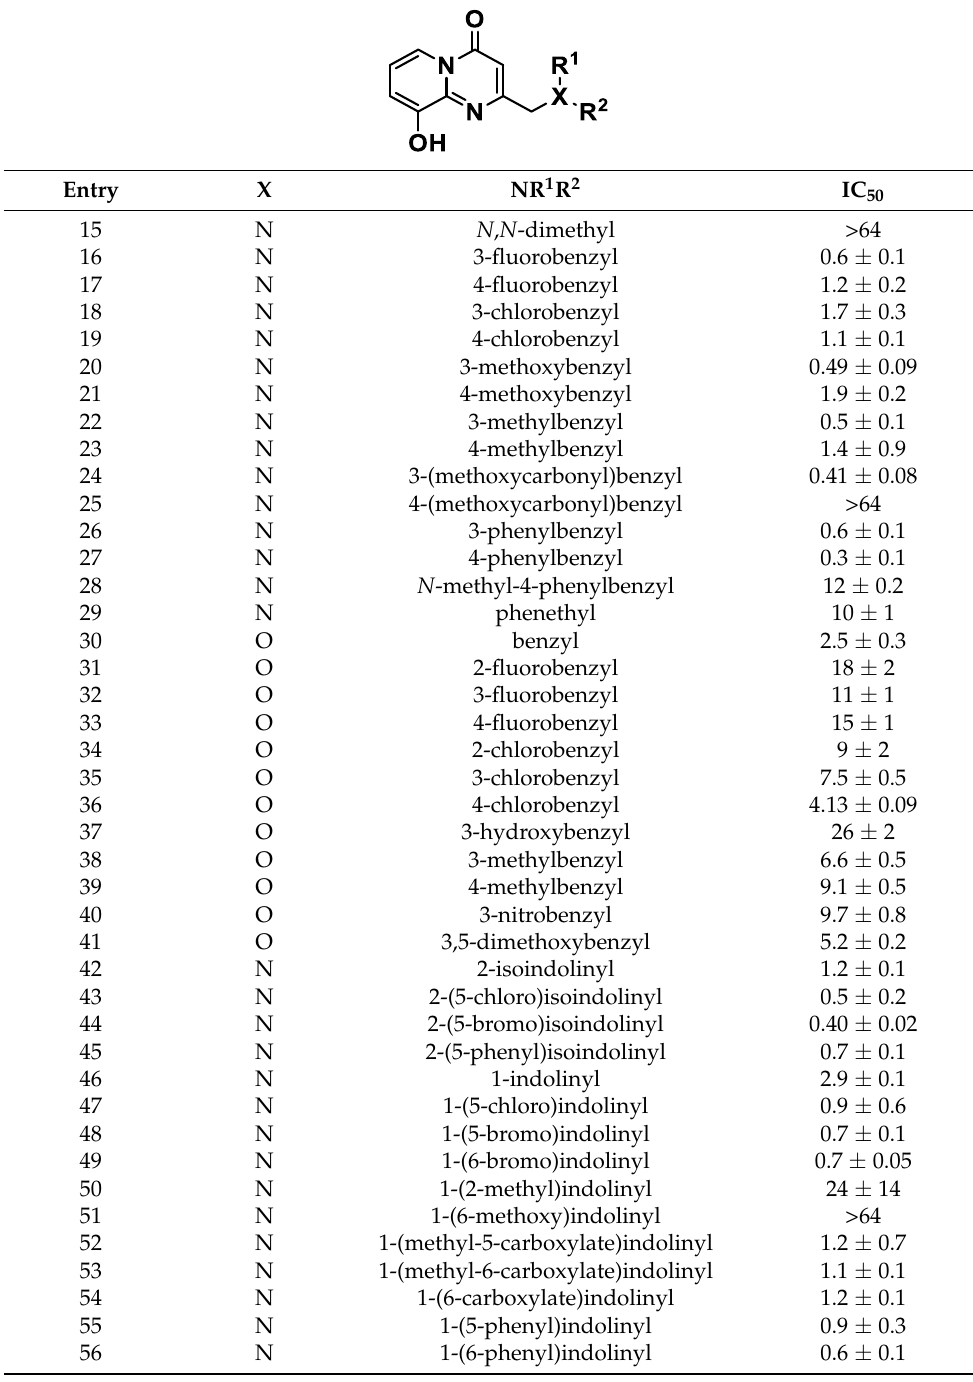
Table 1. IC 50 values for the synthesized PPO library ( n = 3).